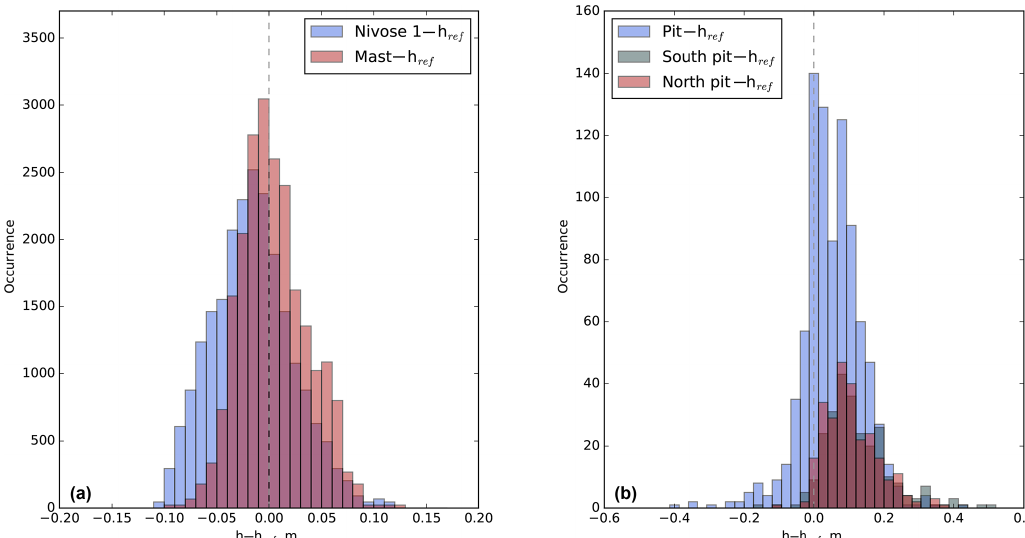
Figure 8. Comparison of snow depth measurements at different locations. The variable h ref corresponds to location 33 (Fig. 2). (a) Difference in measured snow depth between the ultrasound sensor placed at the Nivose 1 location (Fig. 2) and the reference snow depth (locations 32– 33, Fig. 2) in blue. The differences between the measured snow depth at location 6 (Fig. 2) and the reference snow depth are in red. The differences are calculated from the snow season 2009–2010 to the snow season 2015–2016 using only data from 20 September to 10 June. Data where both locations indicate 0 snow depth are excluded from the statistics. (b) Difference in measured snow depth between the manual snow depth measurements at the snow pit field location (Fig. 2) and the automatic reference snow depth (location 33, Fig. 2) in blue, the manual snow depth measurement in the south snow pit field and the reference in grey, and the north snow pit field and the reference in red. Difference values are calculated over the 1960–2017 period for the pit value and over the 2001–2017 period for the north and south pits. Data where both locations indicate 0 snow depth are excluded from the statistics. Corresponding statistics are provided in Table 5. Table 5. Statistics of the comparisons between the different snow depth measurements represented in Fig. 8. Sensors Number of times Deviation (m) RMSD (m) Period Nivose 1– h ref 22498 − 0 .